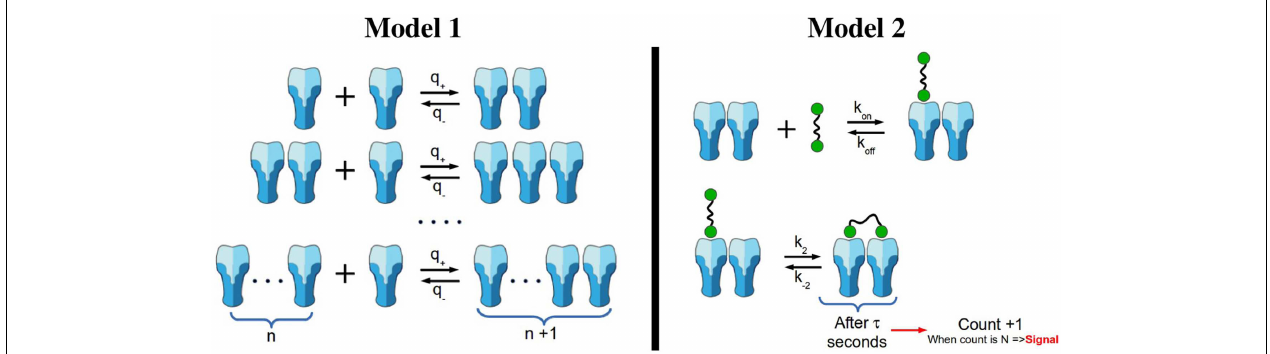
FIGURE 2 | Oligomerization and signaling models . Left panel: oligomerization model not mediated by ligand (Model 1).We assume that receptors are able to diffuse and aggregate to an existing cluster. However, we exclude the possibility of clusters with size larger than one to diffuse. Clusters grow one monomeric unit at a time. Right panel: reactions included in the stochastic activation model (Model 2). Ligands in solution are able to